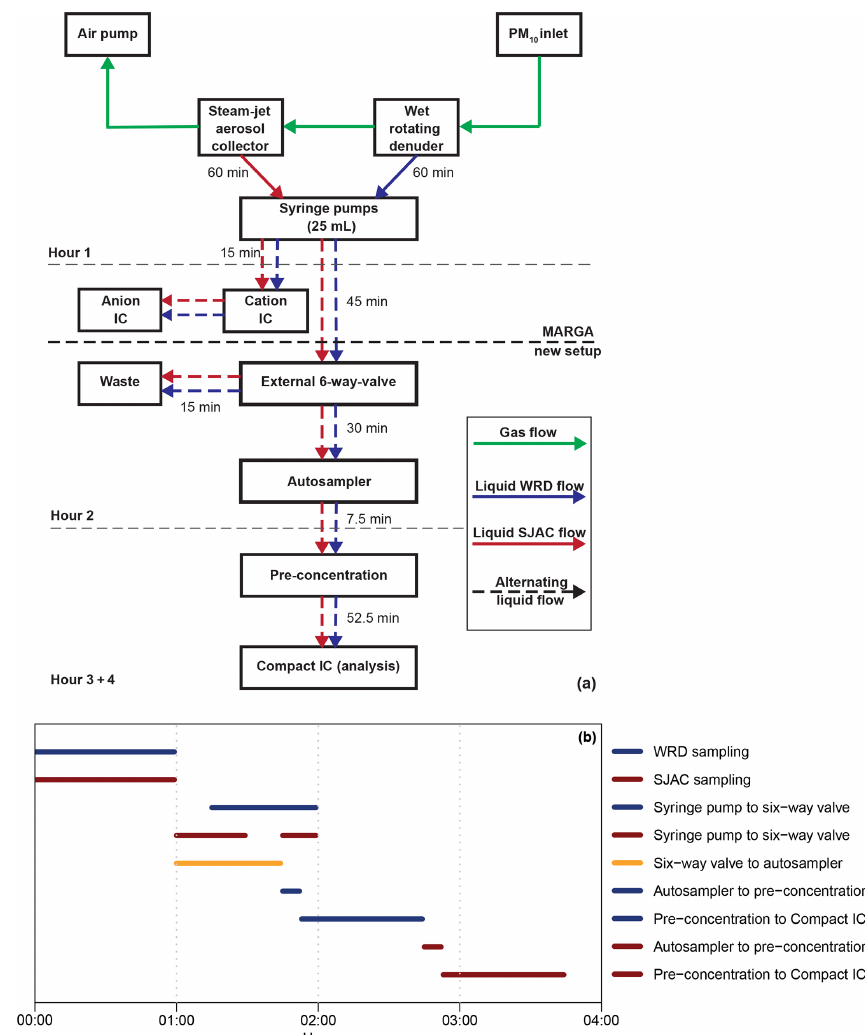
Figure 7. (a) Schematic overview of the sample handling for the complete setup (MARGA, autosampler and Compact IC). Green arrows illustrate gas flow, while blue and red are the aqueous WRD and SJAC samples, respectively. The time on the arrows represents the flow duration. Dashed arrows stand for alternating flows. Dashed grey lines illustrate the hourly time steps, while the bold dashed black line is the border between MARGA and the Compact IC. (b) Time diagram of the liquid handling (blue: WRD; red: SJAC). Black is the open mode of the six-way valve for liquid transport from the syringe pumps to the